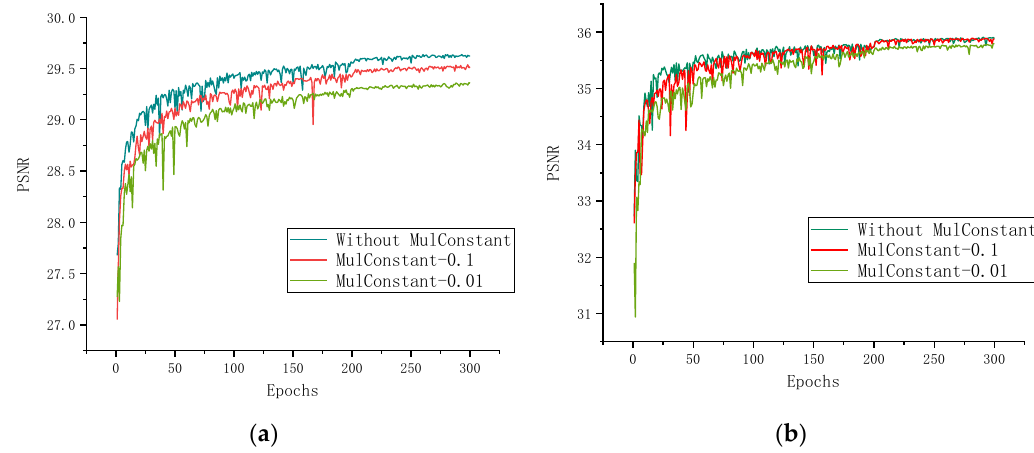
Figure 5. ( a ) Peak signal-to-noise ratio (PSNR) validation of EDSRSP-1 × 1 × 4 models. ( b ) PSNR validation of EDSRSP-3 × 3 × 2 models.